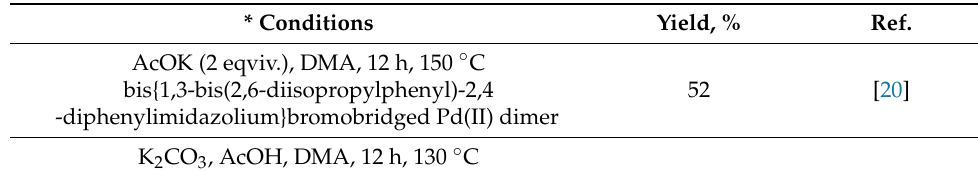
Table 1. Reagents and conditions.